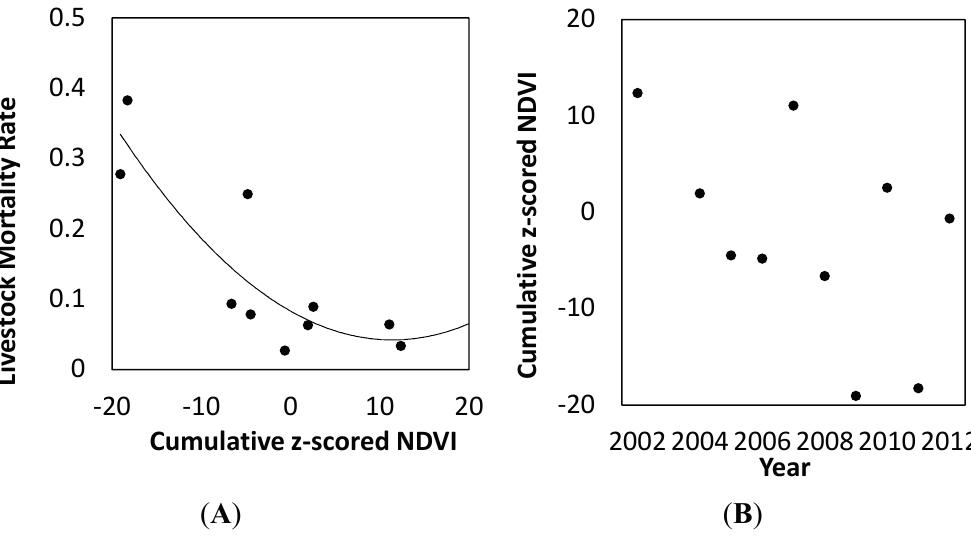
Figure 2. ( A ) Relation between the cumulative z-scored NDVI index and livestock mortality used in design of IBLI livestock insurance and ( B ) Variation of the cumulative z-scored NDVI index over an eleven-year period for Laisamis division in Marsabit district (see Figure 3).